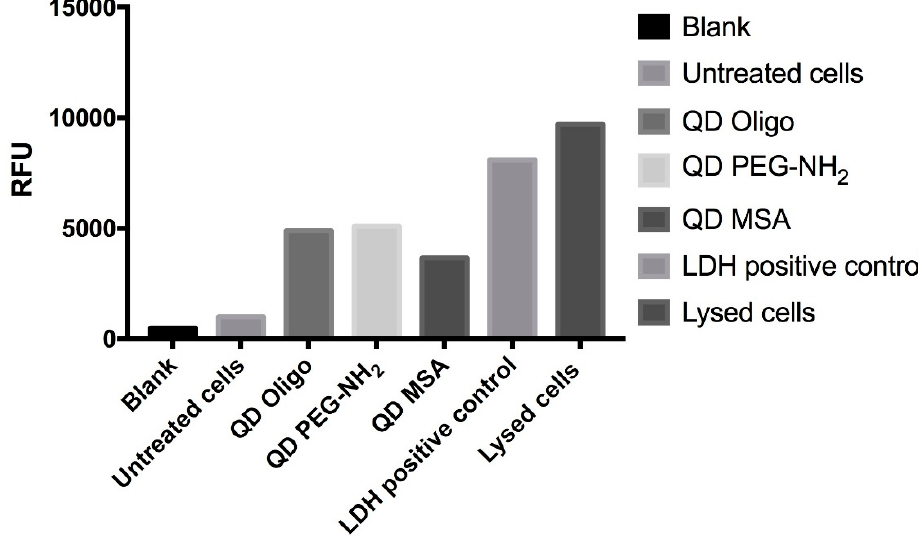
Figure 3. Mean of LDH release from RAW 264.7 cells treated with QDs with ligands Oligo, PEG-NH 2 and MSA at 24 h (48 h is not present) ( n = 3). Data analysis is expressed as the % mean compared to untreated cells, positive control (0.1% Triton X-100), and lysed cells.